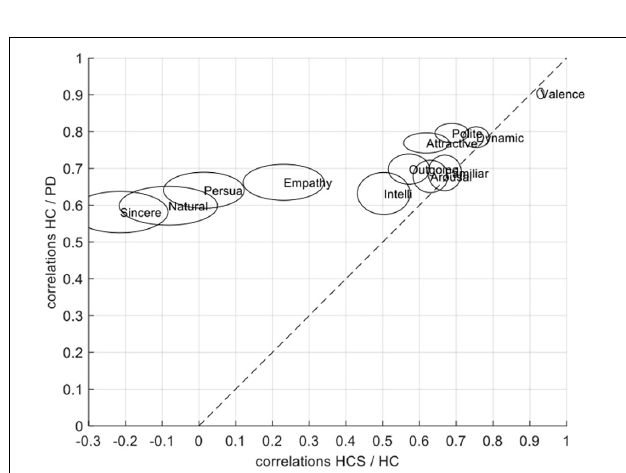
FIGURE 5 | Scatter plot showing the relationship between across-group correlations for HC/PD correlations and HCS/PD correlations for the jointly rated evaluation dimensions. The size of each circle is proportional to the average variability of the correlations as determined in the split-half